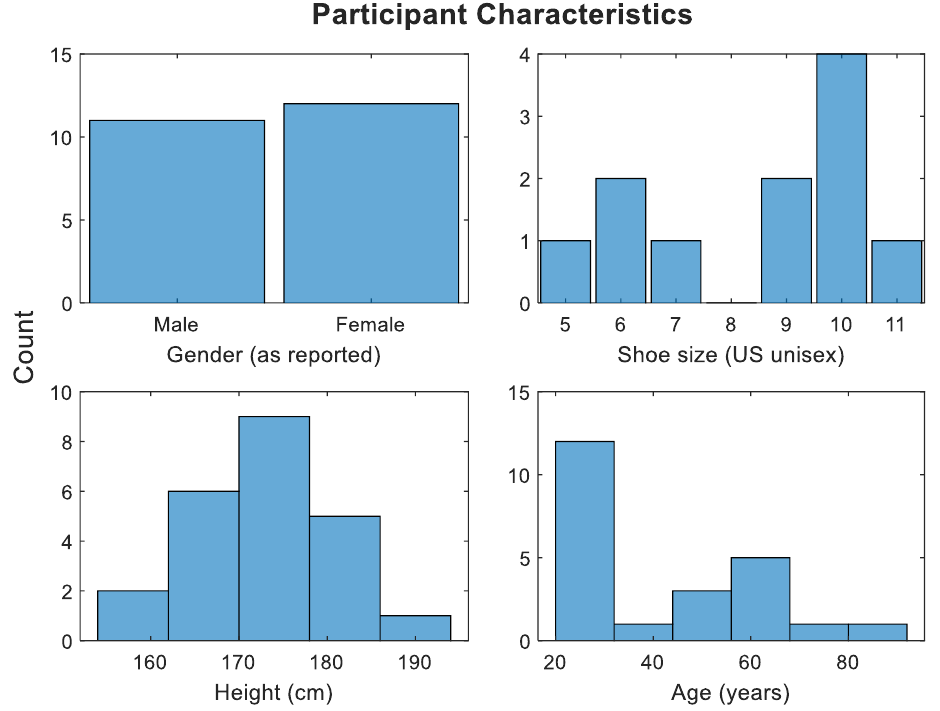
Figure 5. Self-reported participant